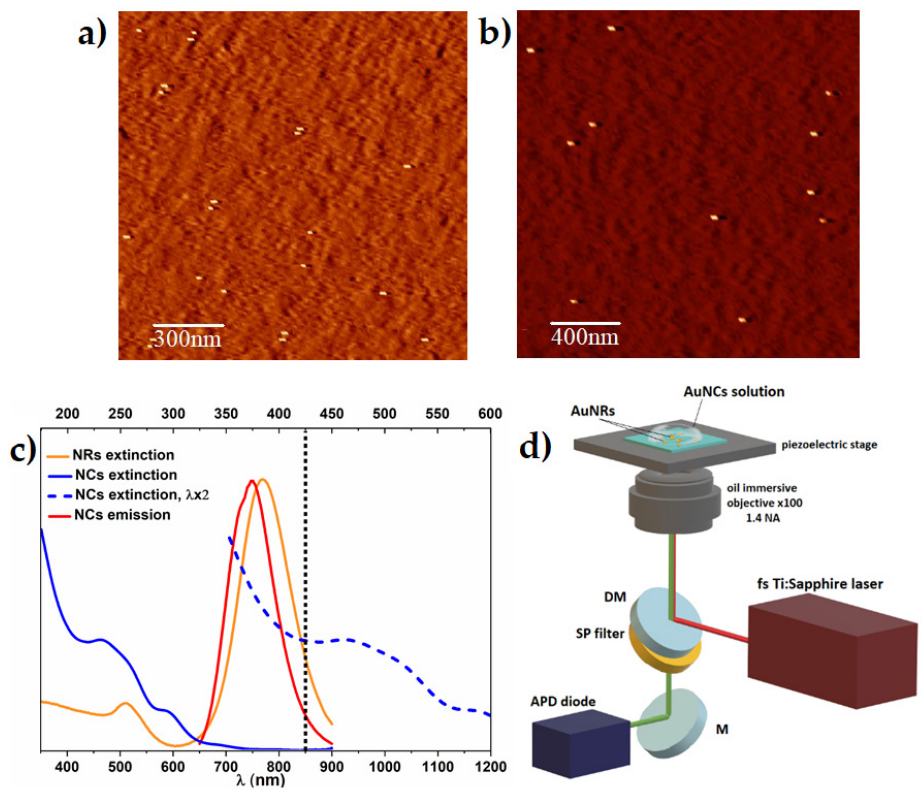
Figure 2. AFM images of ( a ) CTAB-coated and ( b ) bare gold nanorods. ( c ) Spectral overlap of longitudinal surface plasmon resonance band of nanorods (orange) and emission band of Au 18 nanoclusters emission (red). One-photon absorption of nanoclusters (blue solid line) with expected two-photon absorption spectrum (blue dotted line), plotted as one-photon absorption at the double wavelength. Vertical black dotted line represents the laser wavelength used in two-photon excitation ( λ exc = 850 nm). ( d ) A scheme of the experimental setup (NA = numerical aperture, APD = avalanche photodiode, DM = dichroic mirror, and M = mirror). Above the objective and on the top of the piezoelectric stage, glass sample is placed with immobilised gold nanorods and a droplet of nanoclusters diffusing in a glycerol solution.